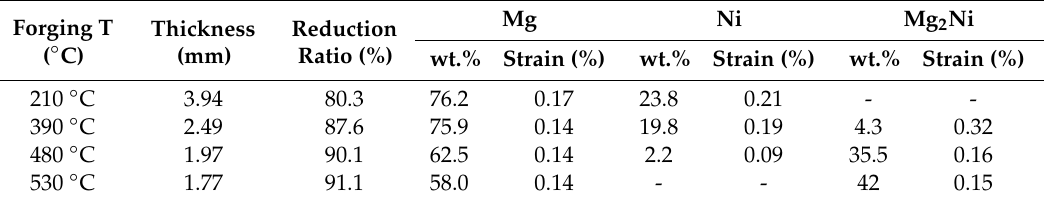
Table 2. Thickness, reduction ratio, and weight fraction (%) of phases in as-forged samples.